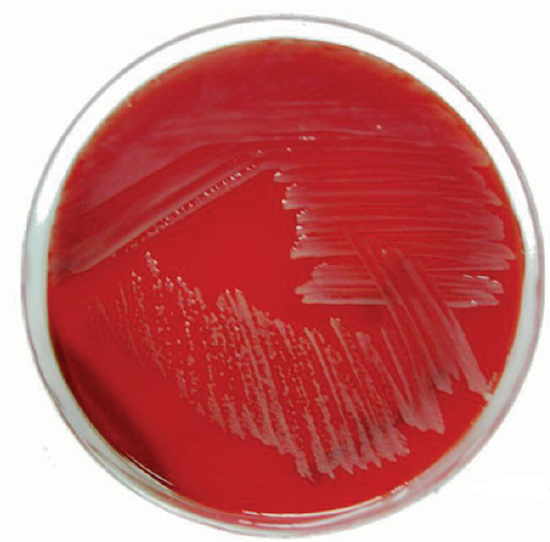
Figure 4. Nonhemolytic colonies on 5% sheep blood